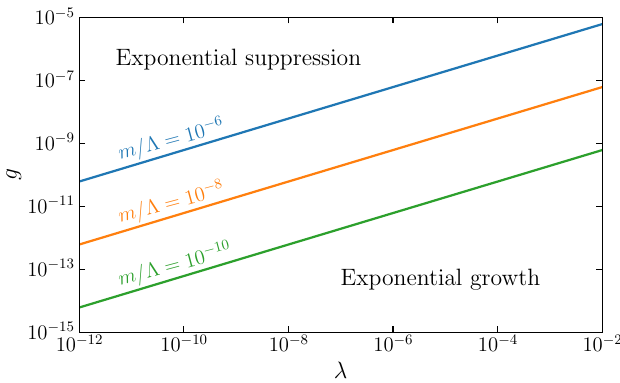
Figure 2 . Parameter space of the EFT with < ( A ) < 0 , spanned by the quartic, g , and sextic self-interactions, λ , of the field. Above the solid lines, the multiparticle amplitudes at the kine- matic threshold are exponentially suppressed. Below the lines, they grow exponentially, thereby indicating a breakdown of (resummed) perturbation theory. The colors illustrate different ratios of energy scales of the EFT. For simplicity, here, we have neglected the tree-level contribution to the multiparticle process (see main